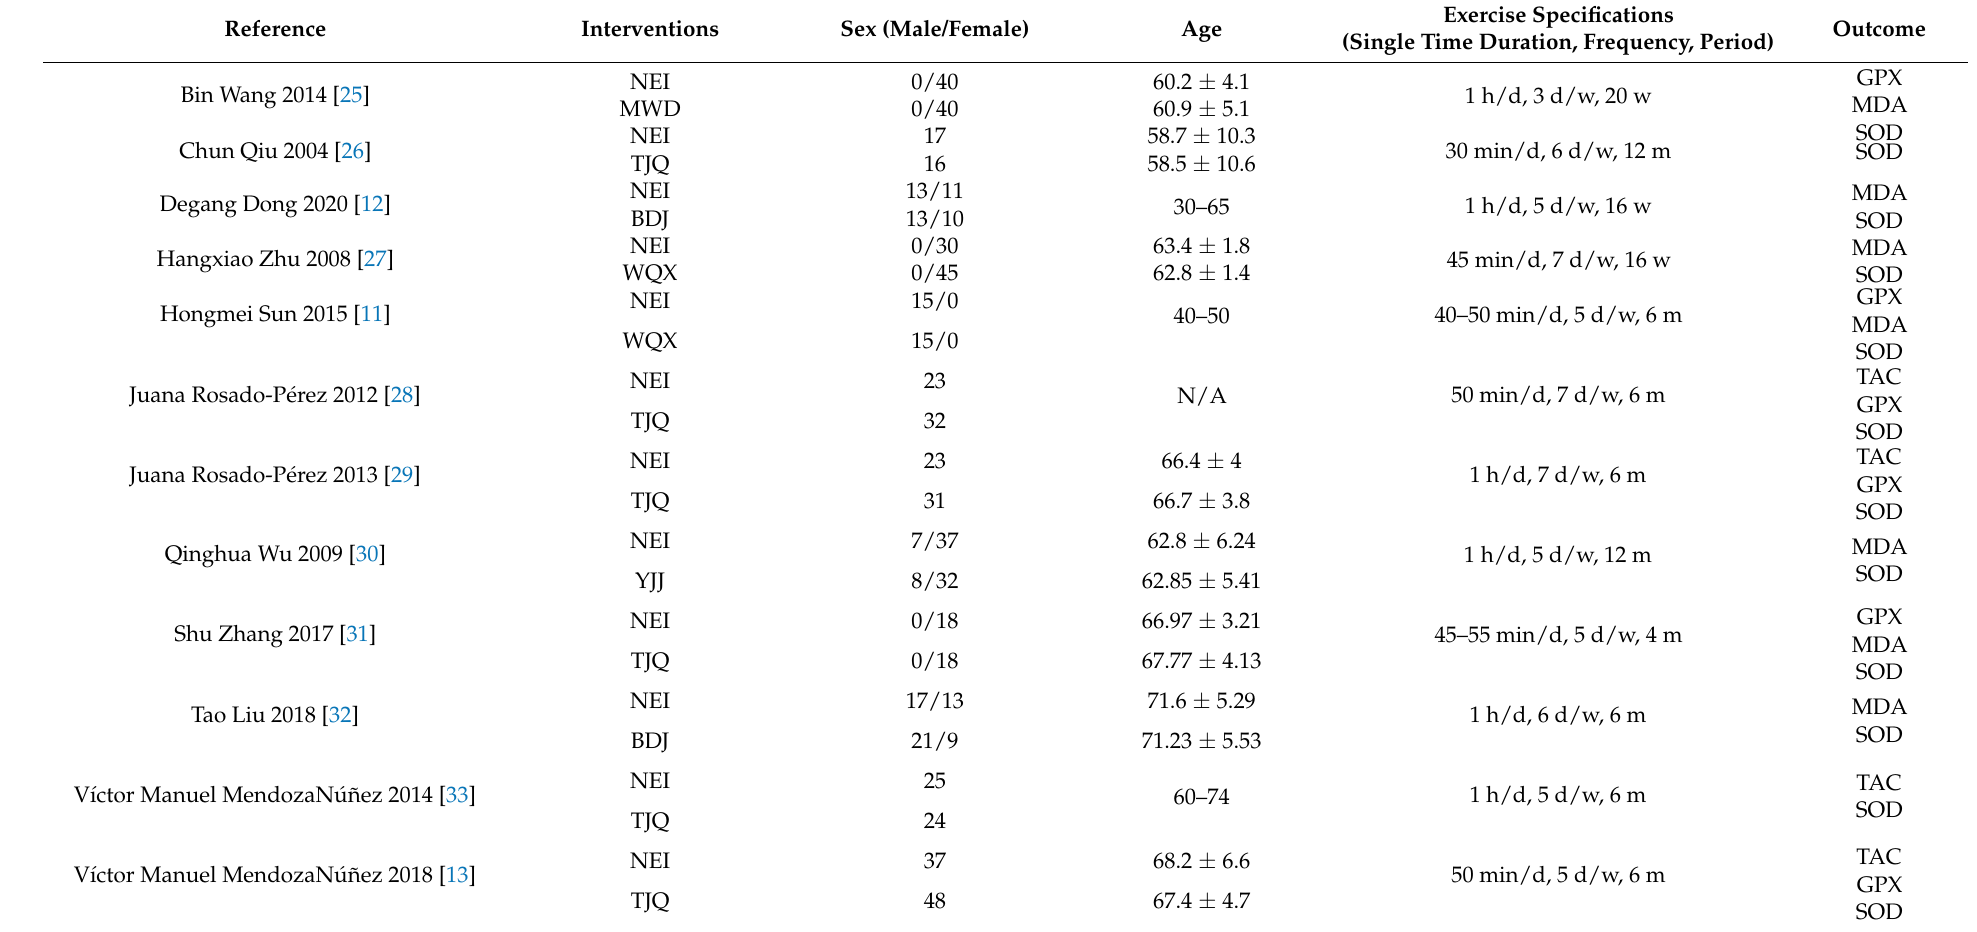
Table 1. Basic characteristics of included